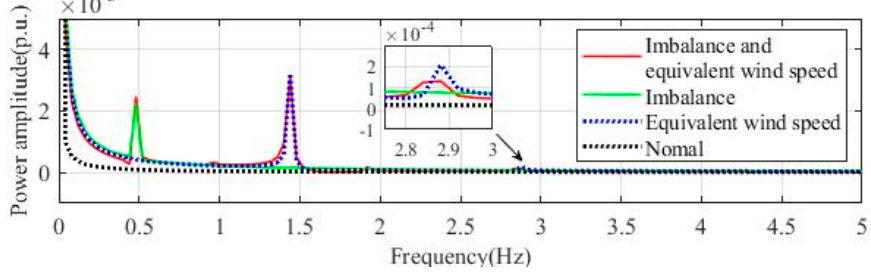
Figure 10. Spectrum of electromagnetic torque.